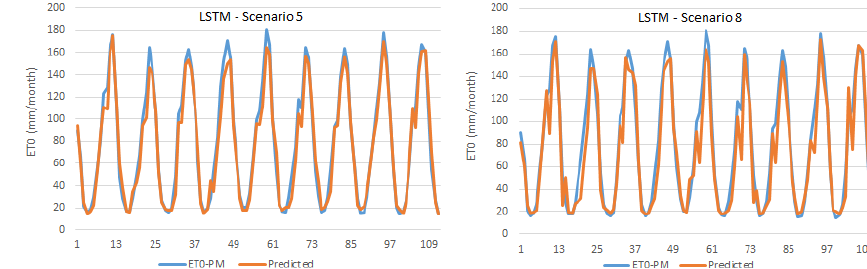
Figure 11. Time series graphics of LSTM-estimated and FAO56PM-estimated ET 0 in scenarios 5 and